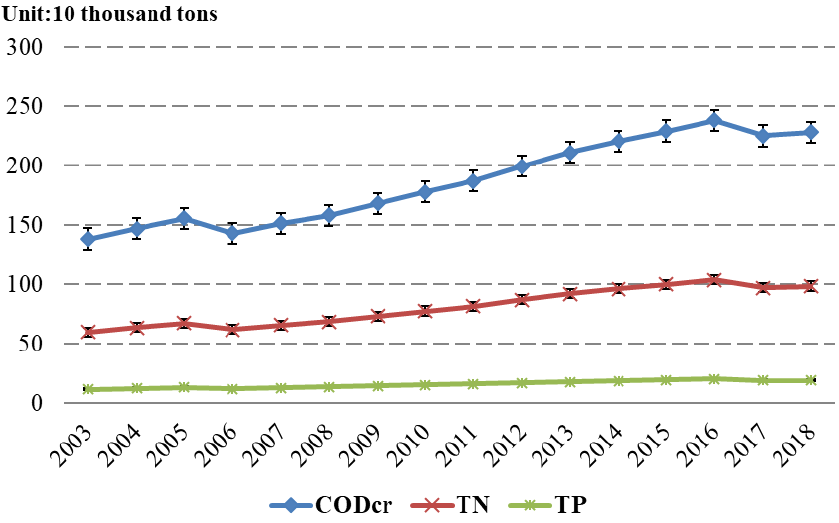
Figure 1. The emissions of major pollutants in China’s aquaculture industry from 2003 to 2018.